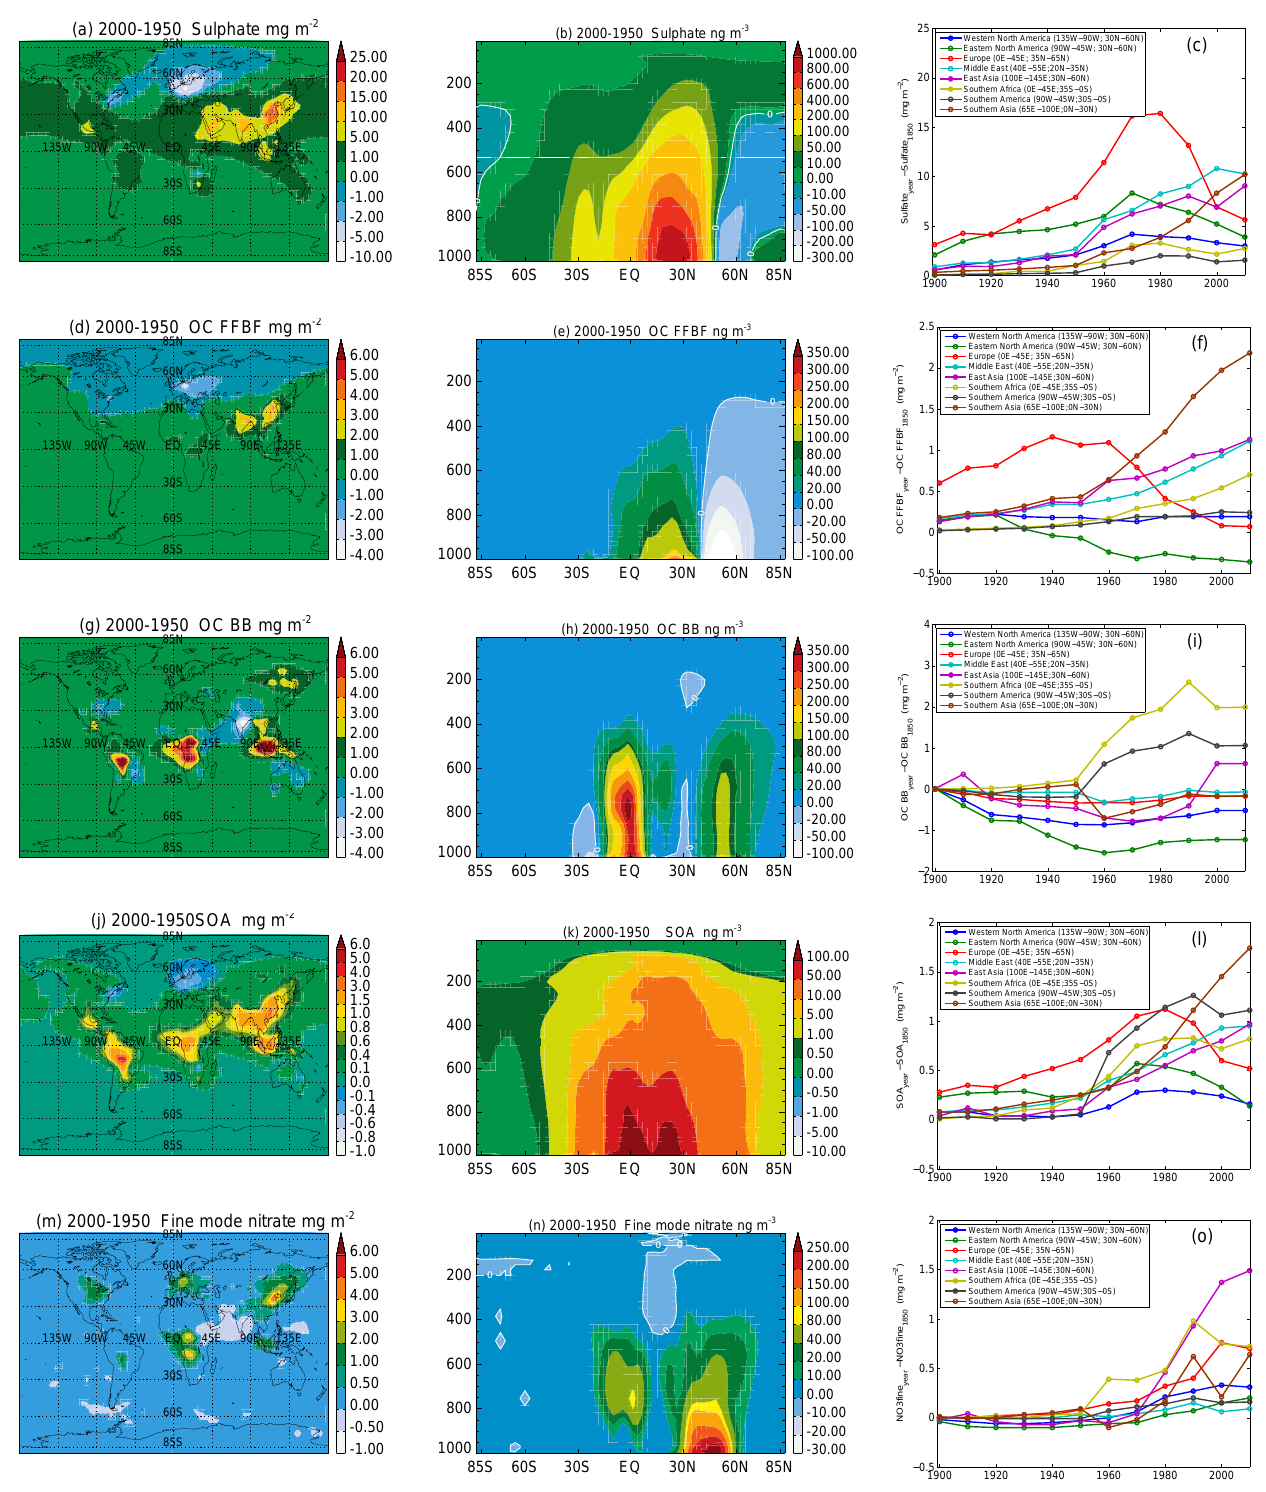
Fig. 9. The 2000–1950 difference in annual mean column load (left column) and annual zonal mean concentration (middle column). The development in regional burden relative to 1850 is shown in the right column. The aerosols included are sulphate, FFBF OC, BB OC, SOA and fine mode nitrate.